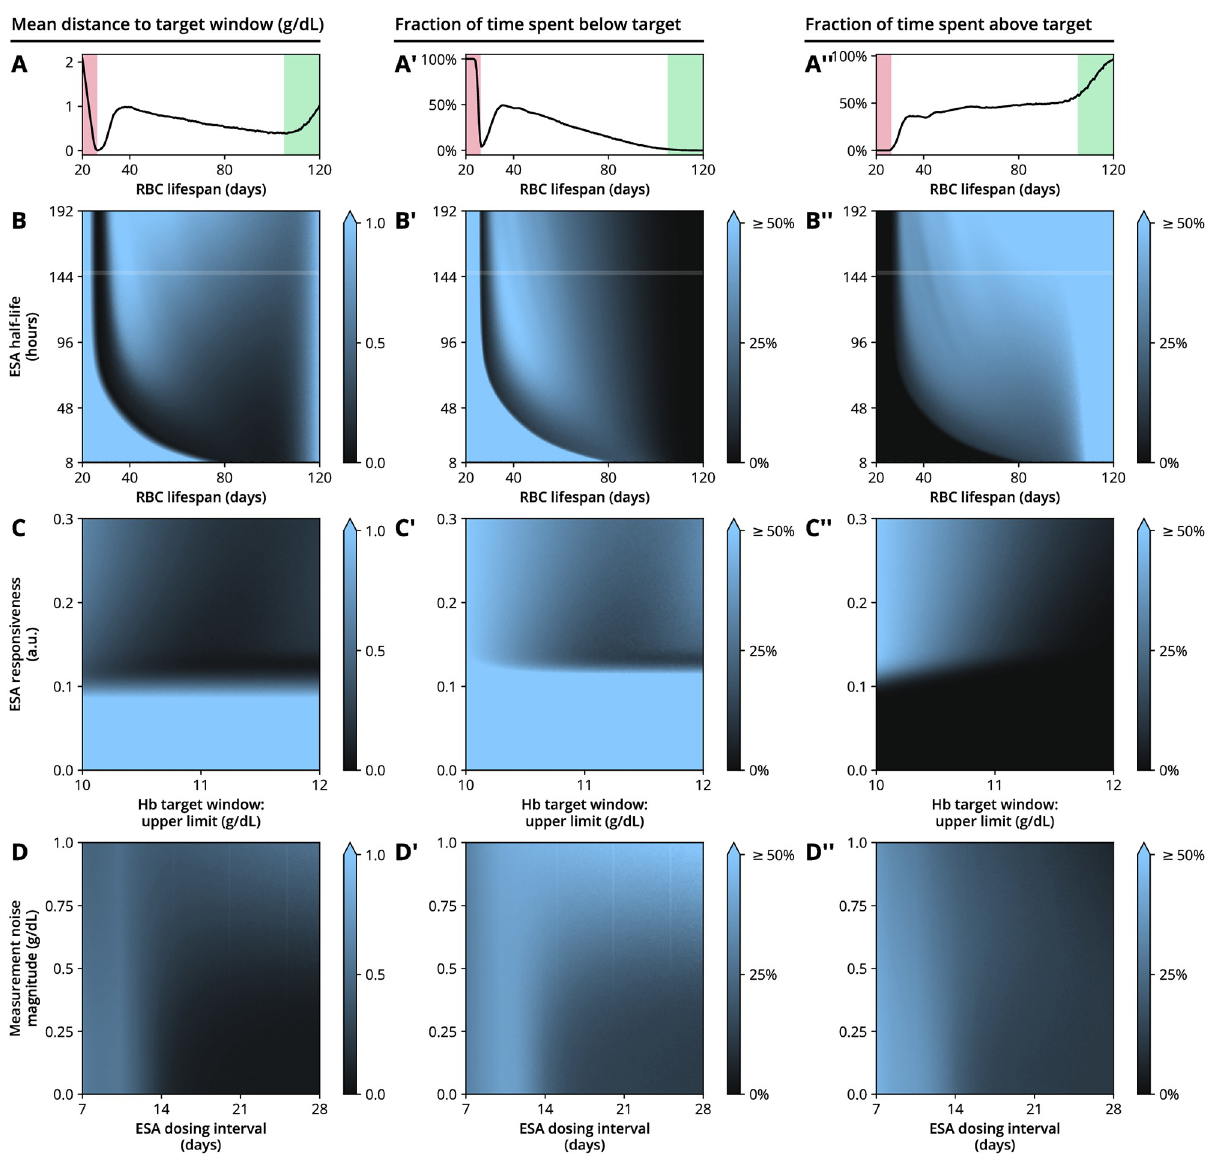
Fig 5. Variability in hemoglobin and ESA administration dynamics for a simulated example patient and treatment setting, where individual physiological and treatment parameters are varied. (A) Mean distance of the ground-truth Hb levels to the specified Hb target range (10–11 g/dL) if RBC lifespan is varied and all other physiological, treatment and ESA parameters are fixed. (A’) Fraction of time the patients spends with Hb levels below the target window and (A”) above the target window as a function of RBC lifespan. In panels A–A”, the red shaded region indicates where RBC lifespan is so small that even repeated administration of the maximum ESA dose cannot achieve Hb target levels, see Eq (15); in the green shaded region, RBC lifespan is high enough to maintain Hb target levels even without ESA therapy, see Eq (16). (B–D”) Contour plots show the indicated quantities if two parameters are varied simultaneously. Columns are organized by quantity displayed and rows are organized by pair of parameters varied. The white line in panels B–B” indicates the cross section of the plot that is displayed in panels A–A”, respectively. Parameters not indicated are fixed to the values provided in Table